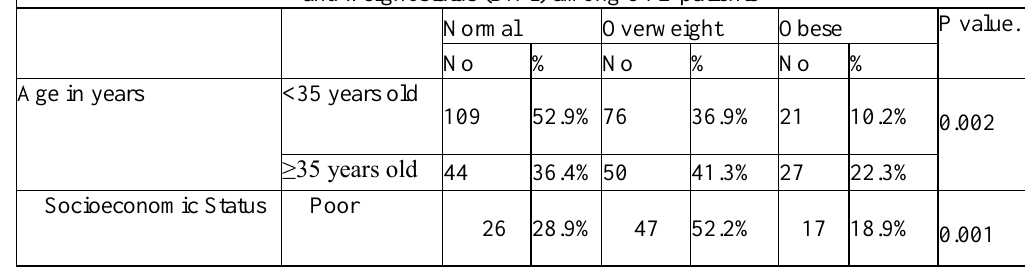
Table 4. Association between sociodemographic